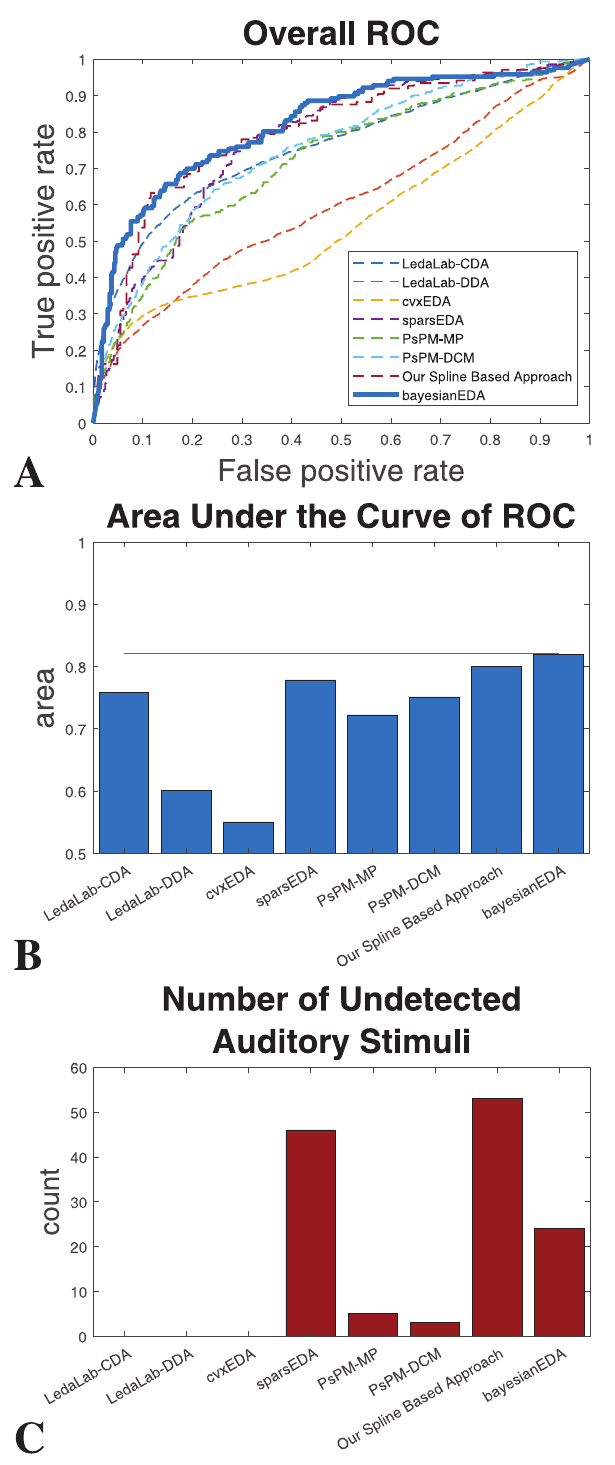
Fig 4. Event related SCR detection performance comparison. (A) The overall ROC curve related to the discrimination power between event-related vs non-event-related SCRs combining all the normalized u from each of the individual participants. (B) Corresponding AUC of the ROC curves. (C) Total number of the undetected auditory stimulation impulses within 26 participants.